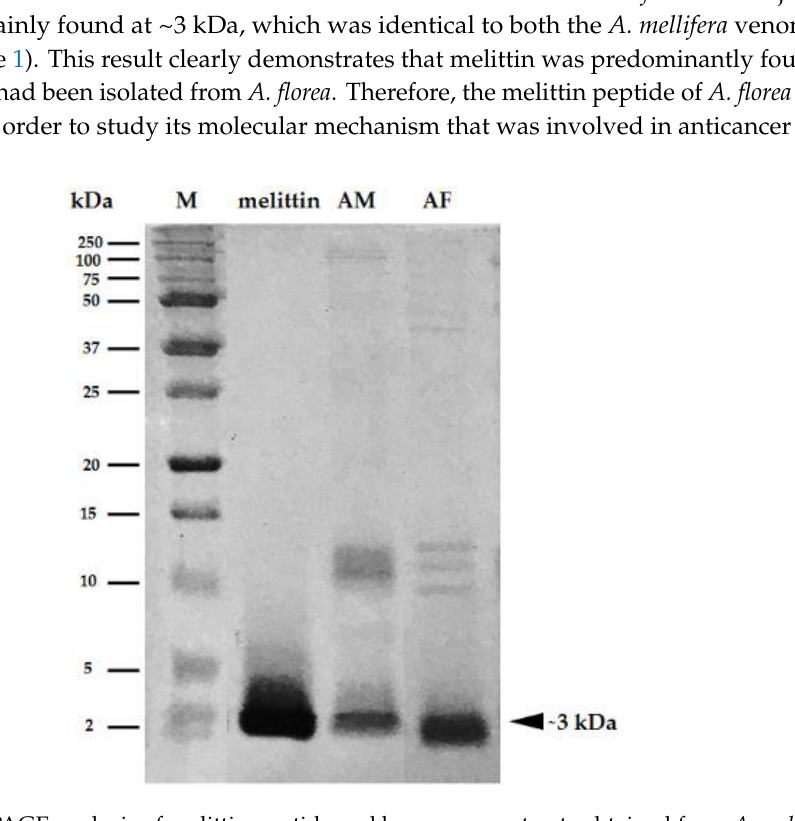
Figure 1. SDS-PAGE analysis of melittin peptide and bee venom extracts obtained from A. mellifera (AM) and A. florea (AF). Melittin peptide and venom extracts were separated on 15% SDS-PAGE and the patterns of the protein in all samples were visualized by 0.1% Coomassie Blue R250 staining. The major protein component was mainly found at ~3 kDa indicating melittin.